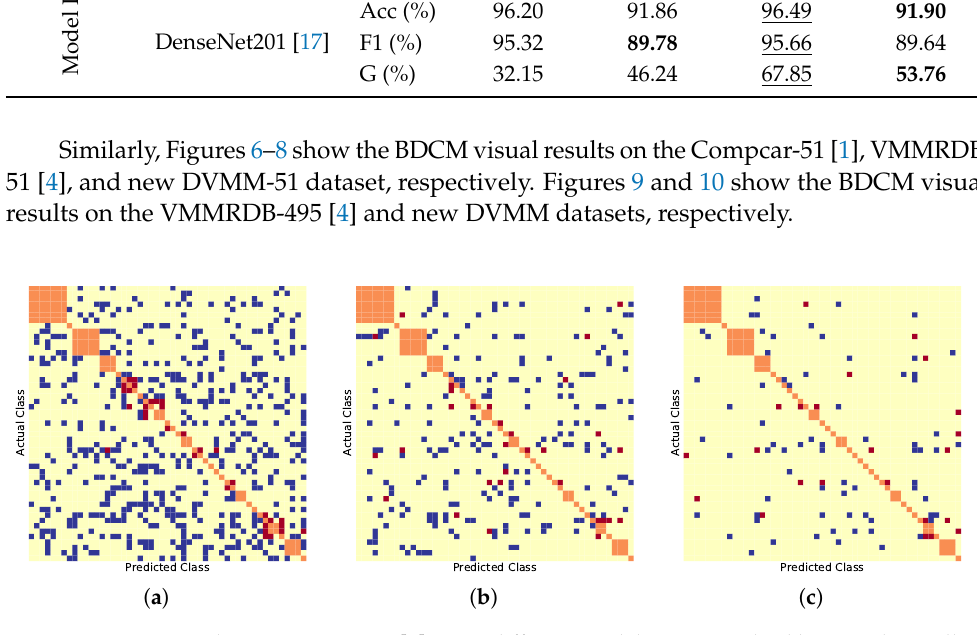
Figure 6. BDCM results on Compcar-51 [1] using different model recogniser backbones. Blue, yellow, and red dots mark the positions filled in with 1, 0, and − 1, respectively. Orange dots mark the different vehicle models that have the same make. ( a ) AlexNet [15] backbone, (#blue, #yellow, #red) = (511, 1925, 32). ( b ) ResNet50 [16] backbone, (#blue, #yellow, #red) = (205, 2232, 31). ( c ) DenseNet201 [17] backbone, (#blue, #yellow, #red) = (71, 2374, 23).